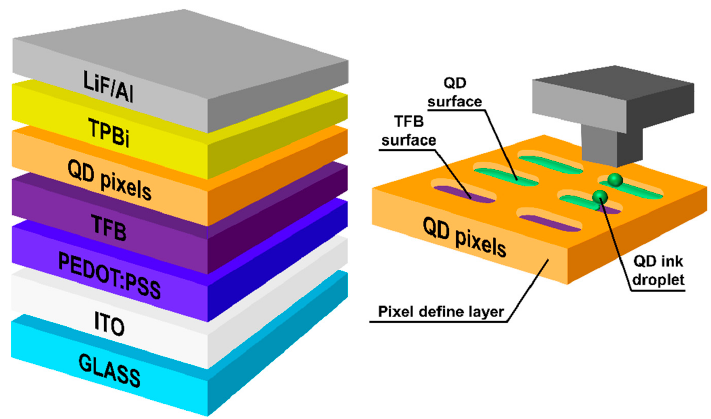
Figure 4. Schematics of ink-jet printed QLED structure and ink-jet printed QD EML pixel arrays.